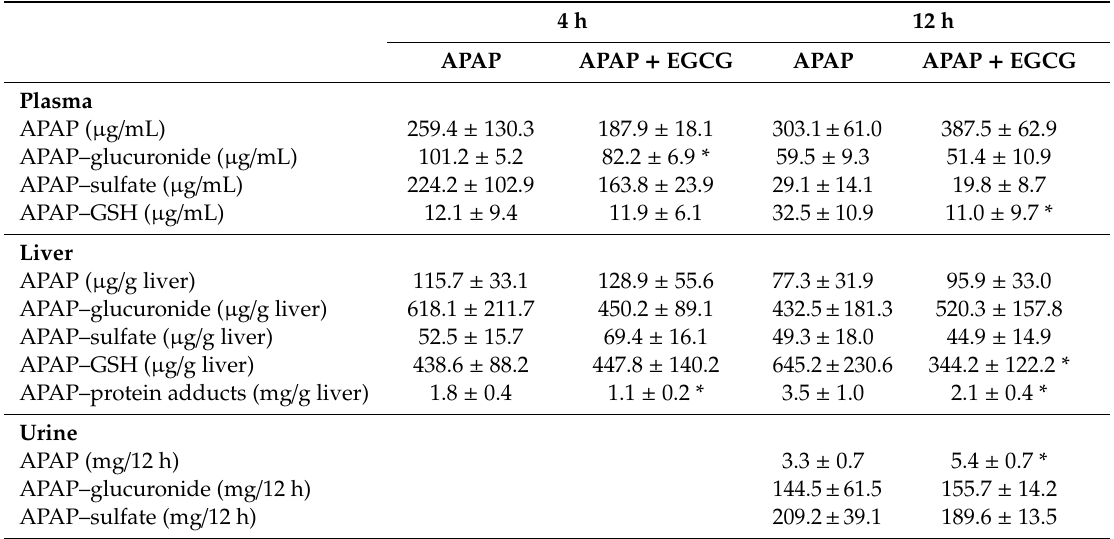
Table 2. APAP and its metabolites in the plasma, liver, and urine after APAP challenge for 12 h a